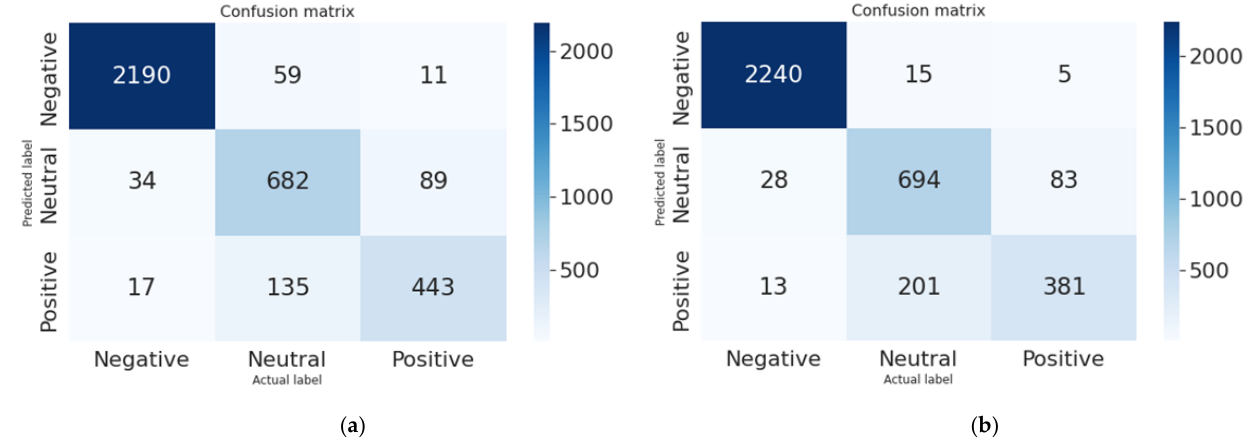
Figure 6. ( a ) Confusion matrix–SVM classifier with best accuracy and ( b ) confusion matrix–GB classifier with second best accuracy